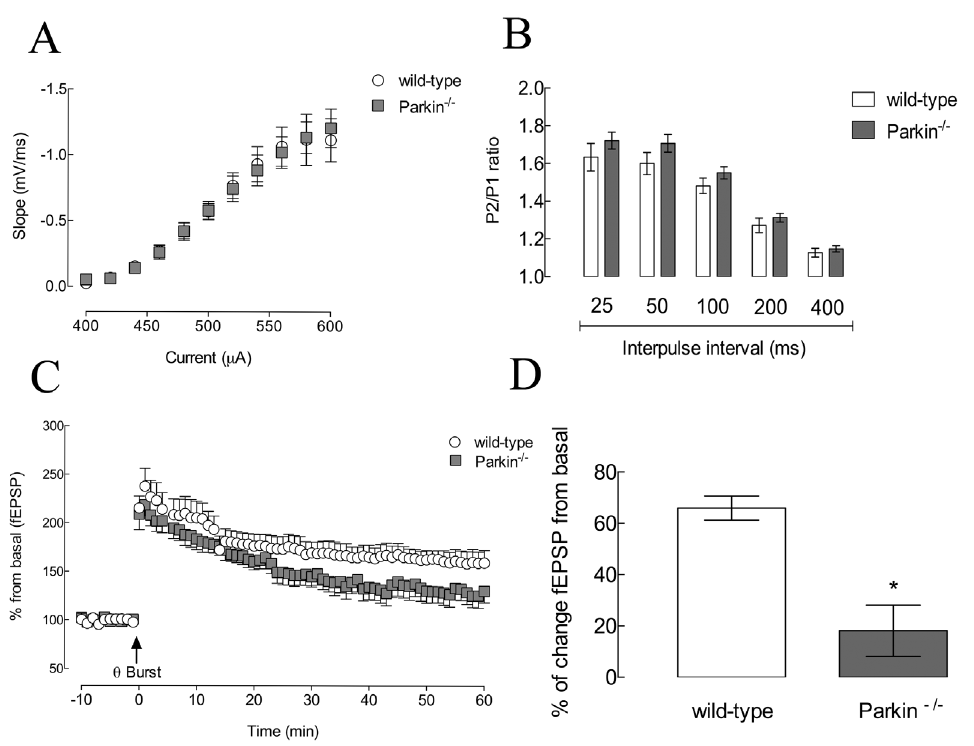
Figure 4. Effects of parkin genetic deletion on hippocampal synaptic transmission and plasticity processes. (A) Input-output curve of field excita- parkin 2 / 2 mice. (B) Paired pulse facilitation (PPF), measured as the ratio of fEPSPs’ slope ratio between the second and first paired stimuli (P2/P1 ratio) with different interpulse intervals (25, 50, 100, 200 and 400 ms) recorded in hippocampal slices from wild-type and parkin 2 / 2 mice. (C) Modification of fEPSPs’ slope, presented as % of baseline, before and after h -burst stimulation in slices from wild-type and parkin 2 / 2 mice. (D) Potentiation of fEPSPs’ slope after the h -burst stimulation, presentage as % increase of baseline fEPSPs’ slope, in slices from wild-type and parkin 2 / 2 mice *P , 0.05 compared to wild-type control group. Data are mean ¡ s.e.m. of n 5 4 per